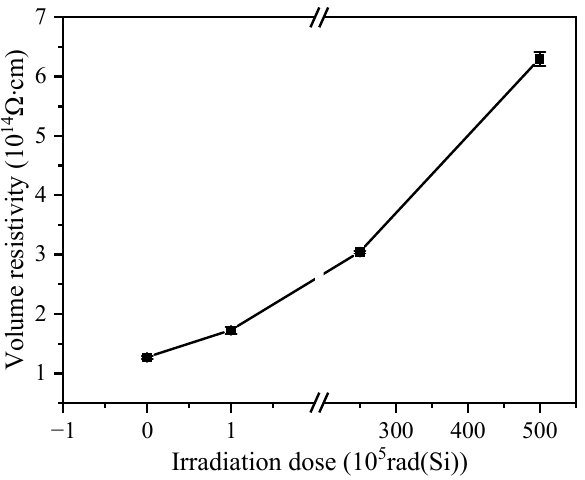
Figure 14. Volume resistivity.